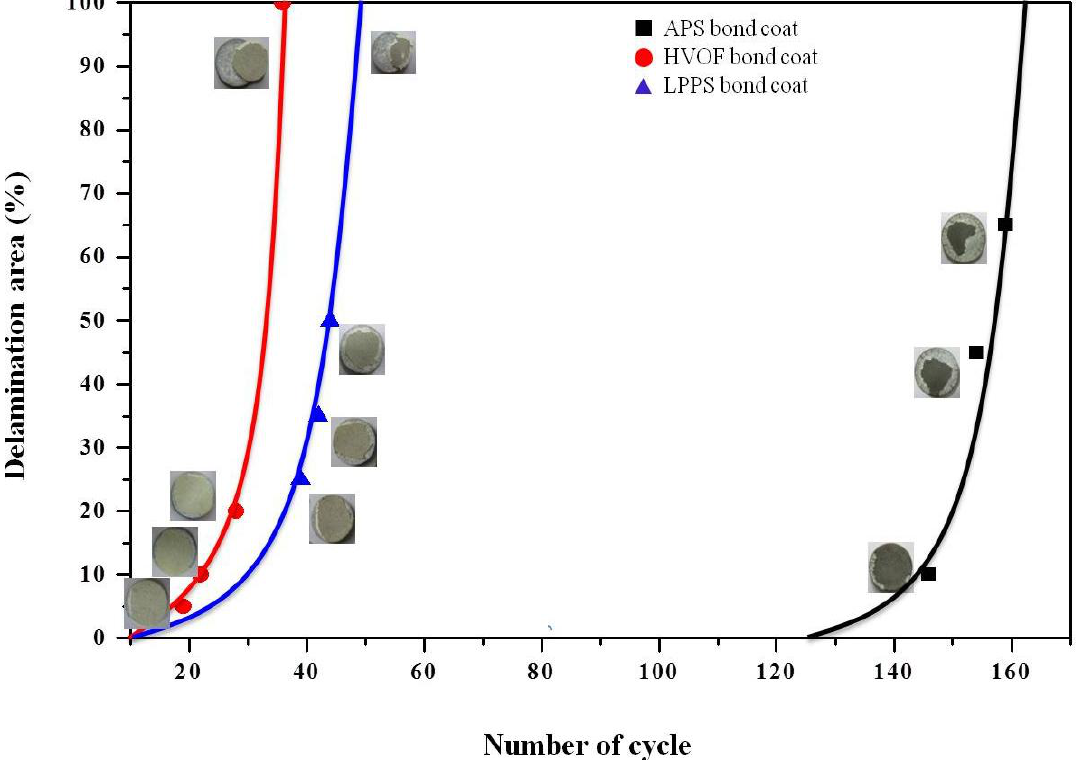
Figure 7. Variation of delamination area with thermal fatigue cycle in thermal-shock tests. The solid curves are empirical data fits.